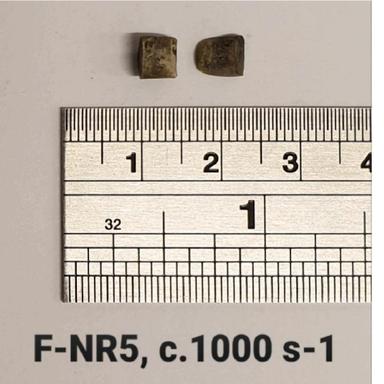
Post-mortem examination for high strain rate experiments at T ≈ − 55 ◦C for F-NR5 at c. 1000 s − 1 .